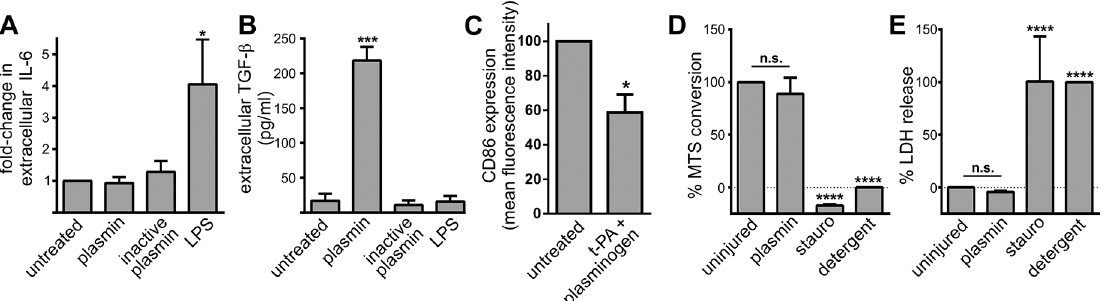
Fig 3. Plasmin-treatment increases TGF- β release, but not the maturity or viability of MoDCs. A and B) MoDCs were treated with 10 nM active plasmin or inactive plasmin or 500 ng/mL LPS. After 48 h, the concentration of IL-6 (Panel A) and TGF- β (Panel B) in the conditioned media was determined. Data are displayed as mean ± s.e.m (n = 4 independent experiments). IL-6 data was normalized to untreated MoDCs. * p < 0.05 and *** p < 0.001 by 1-way ANOVA with Newman-Keuls post-hoc analysis. C) MoDCs were incubated in the presence/absence of 1 nM t-PA+100 nM plasminogen. 24 h later the cell surface expression of CD86 was assessed via flow cytometry. The mean fluorescence intensity of the CD86 signal was normalized to that of untreated MoDCs. Data are displayed as mean ± s.e.m (n = 3 independent experiments). * p < 0.05 by 2-tailed Welch ’ s unequal variances t-test. D and E) MoDCs were treated with 100 nM plasmin or 200 nM staurosporine (stauro) for 24 h. Cellular metabolism (Panel C) and plasma membrane integrity (Panel D) were assessed by the MTS and LDH assays respectively. Data was normalized to the values for untreated cultures and detergent-treated cultures. Data are shown as mean ± s.e. m. (n = 2 for staurosporine-treatment and n = 5 independent experiments for all other groups). **** p < 0.0001 by 1-way ANOVA with Newman-Keuls post-hoc